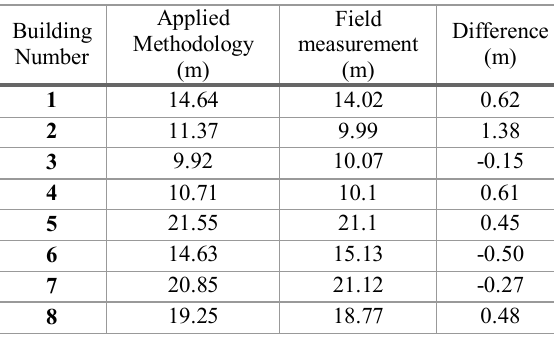
Table 1. Obtained and measured building heights and their differences.